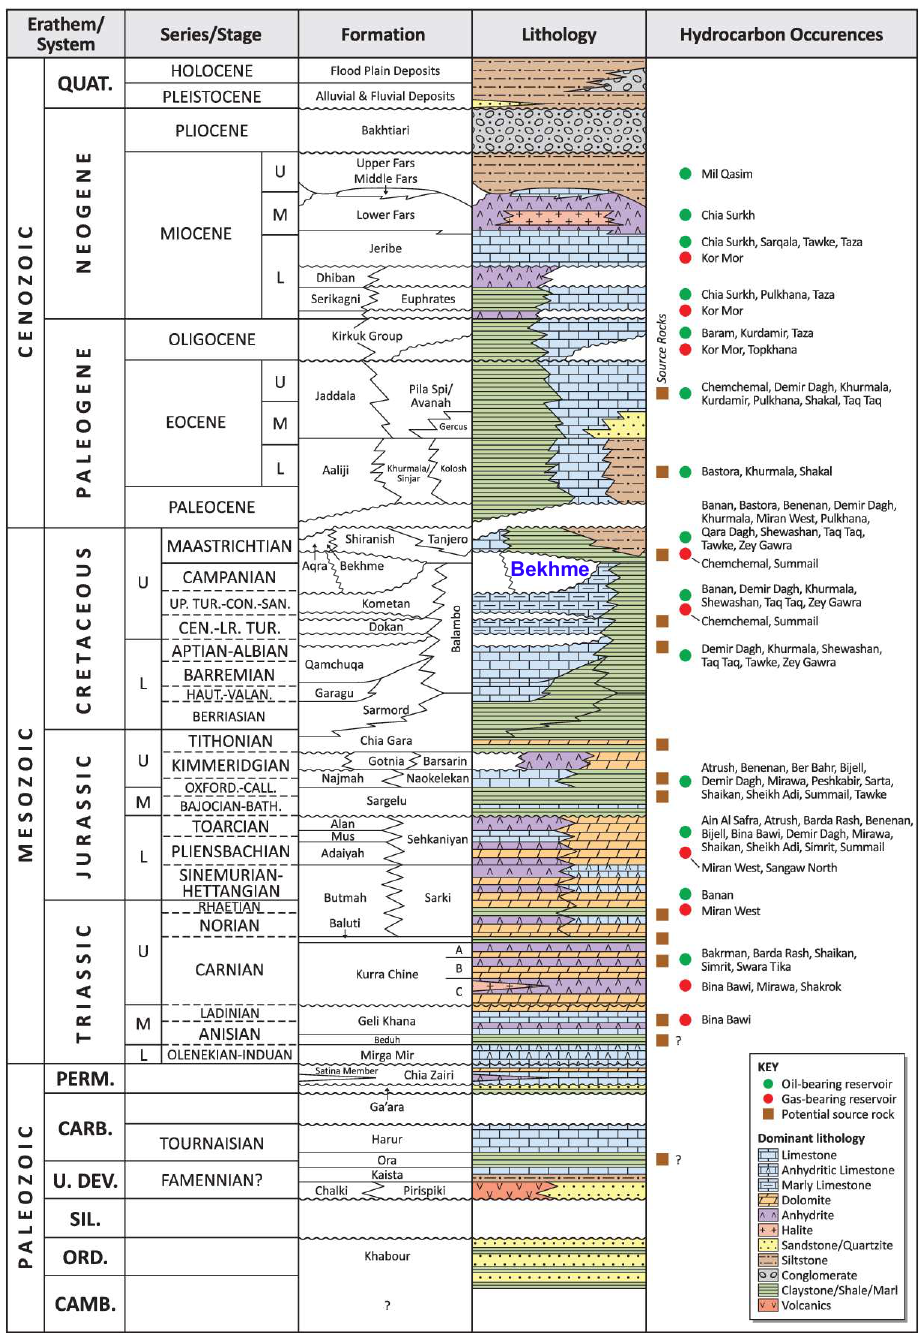
Figure 3. Phanerozoic stratigraphic column illustrating the age, lithology, and nomenclature for the principal stratigraphic units and tectonic events for the northwest (NW) Zagros foreland basin in the Kurdistan region of Iraq (after Reference [9]).